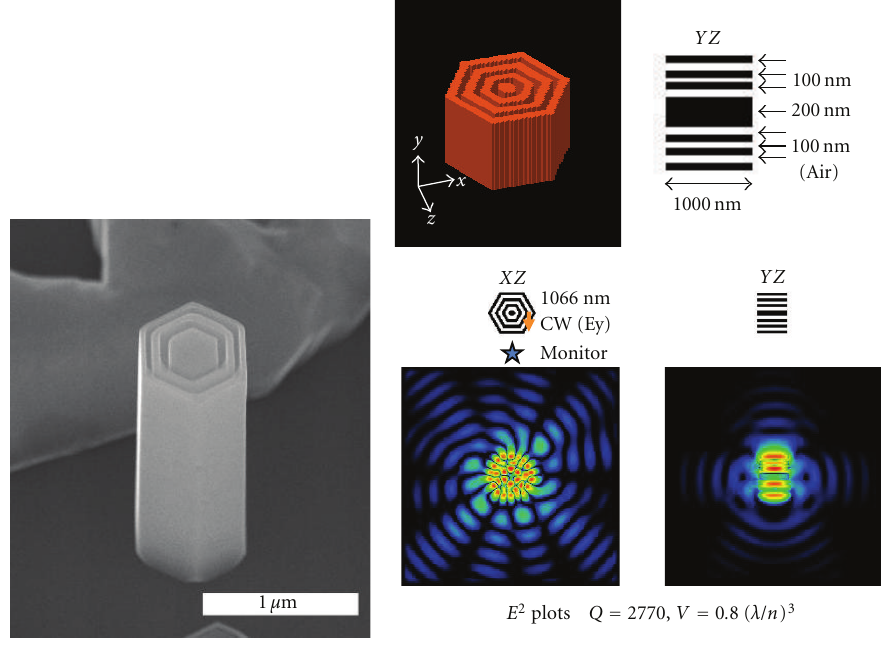
Figure 4: (a) SEM image of core-multishell (GaInP/air-gap) 2 /GaInP/GaP nanowires on Si(111). (b) One simulation result by 3D-FDTD for the illustrated